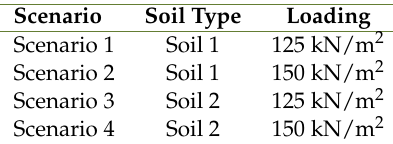
Table 2. Scenarios of